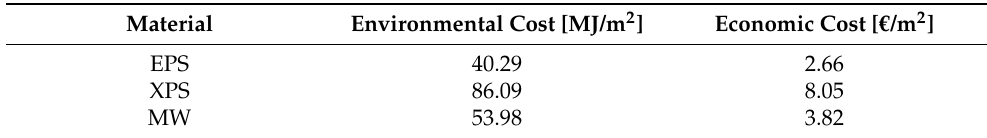
Table 3. Environmental and economic costs of the thermal insulation materials for a functional unit R = 1 m 2